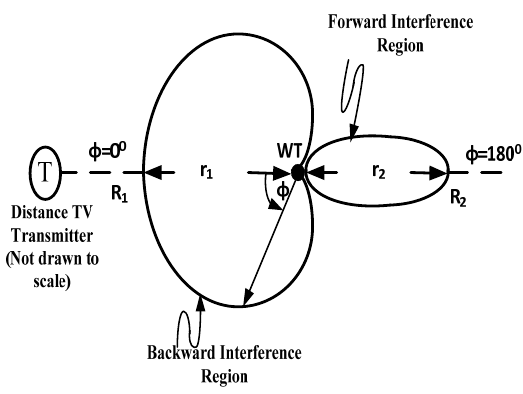
Figure 8. Proposed interference zone by Sengupta [51].